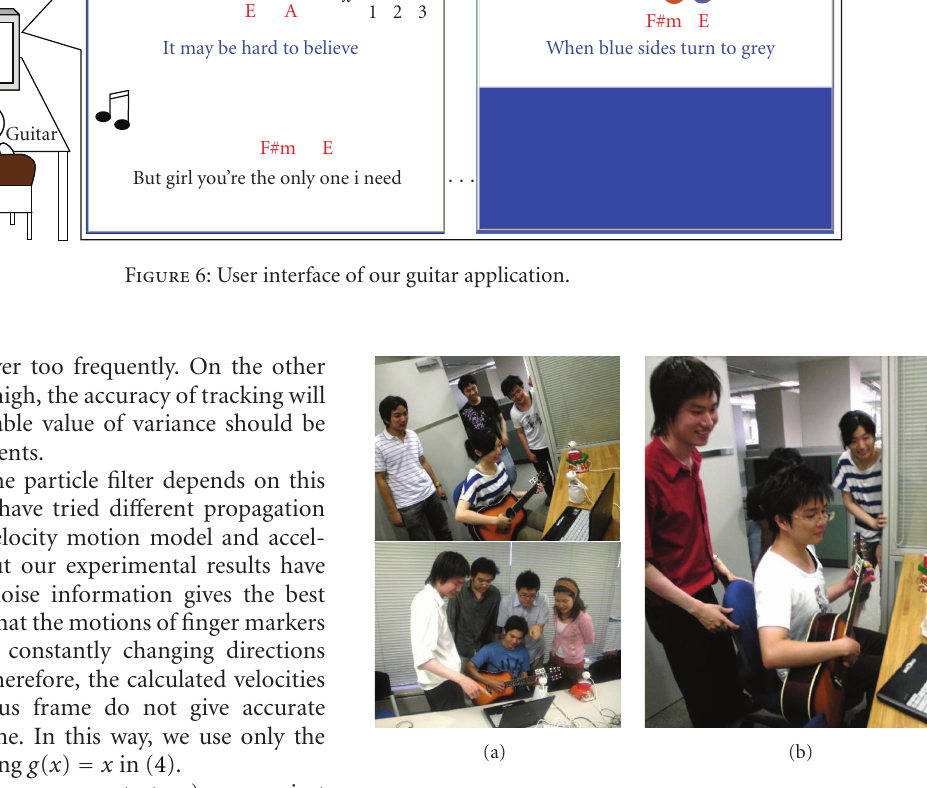
Figure 7: The system environment while users were testing our